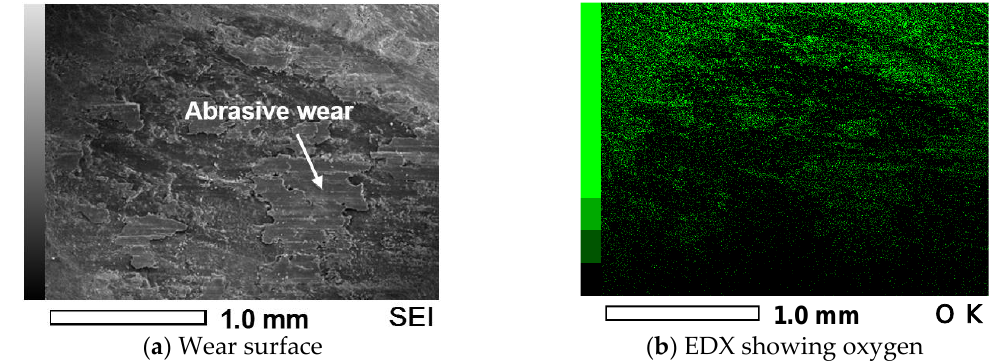
Figure 8. SEM image of wear track formed on the C/C-SiC composite at temperature 200 °C showing the wear mechanism along with oxidation state.